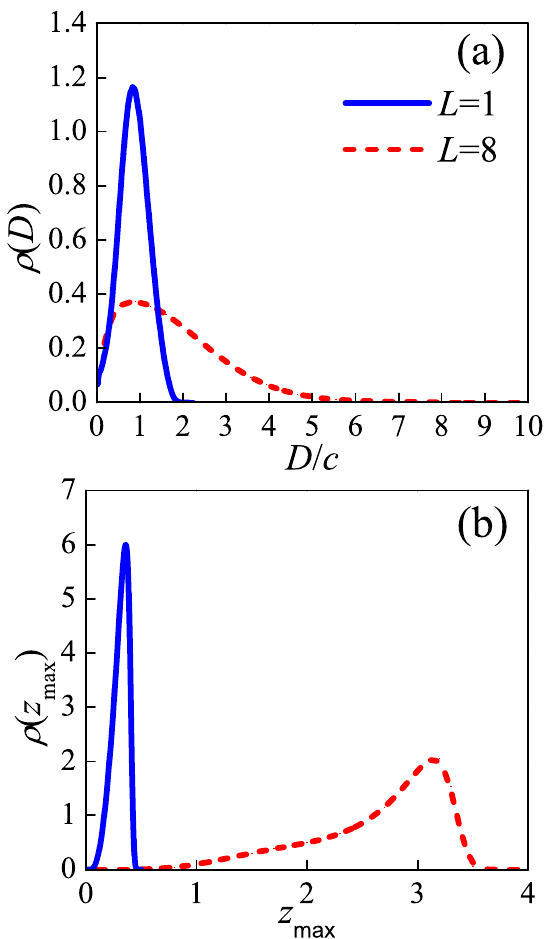
Figure 2. The distribution profile of ( a ) the distance between two injection points D , and ( b ) the distance between the lamellae edge and the highest point in the loop z max . D is scaled by lattice constant c , and z max is scaled by L /2. The blue solid lines and red dash lines represent the tight fold ( L = 1) and loose loop ( L = 8),